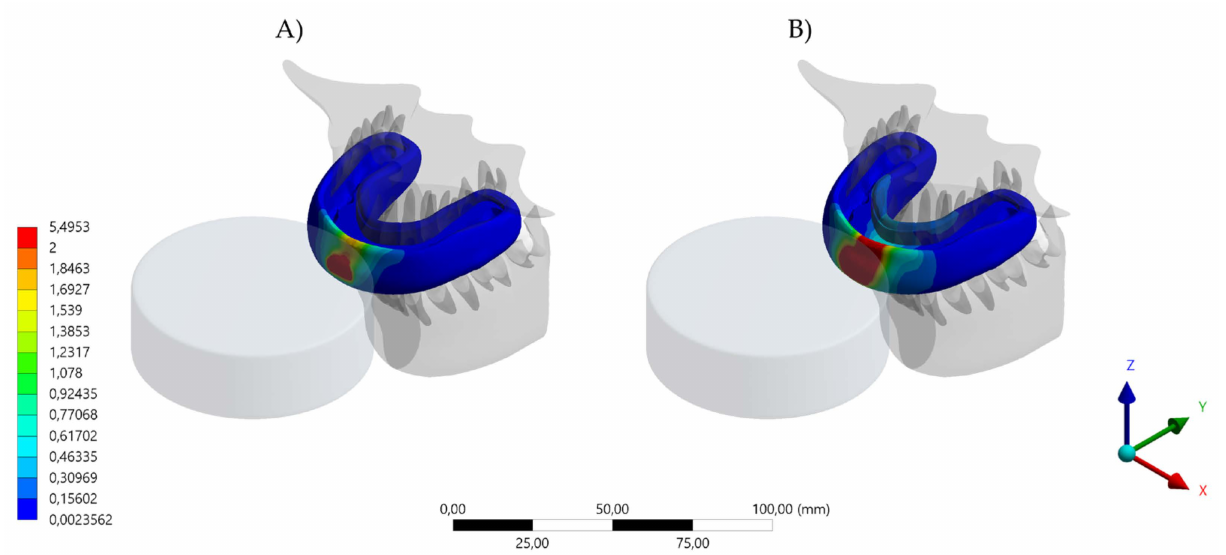
Figure 4. Total deformation result in the MG. ( A ) Device displacement with the conventional design and ( B ) device displacement with the hybrid (HMG) design.